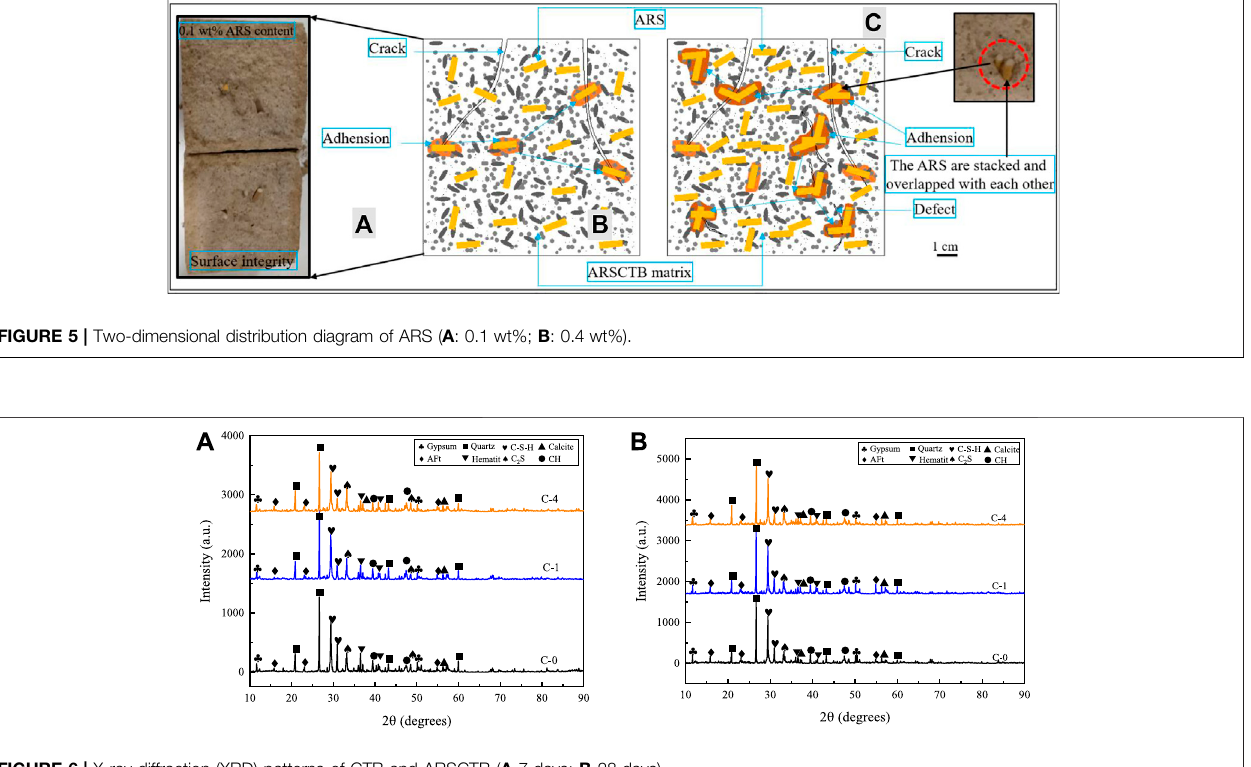
Frontiers in Materials |